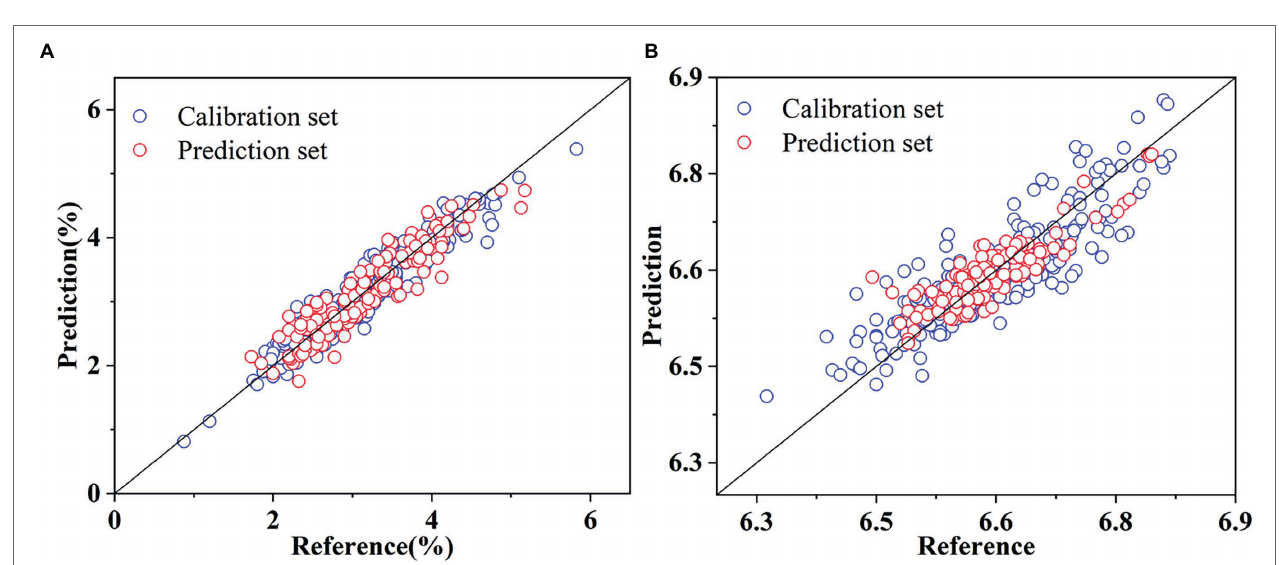
FIGURE 8 | Prediction of SSC based on LWR and SDR (A) , and pH based on LWR and MWS (B)